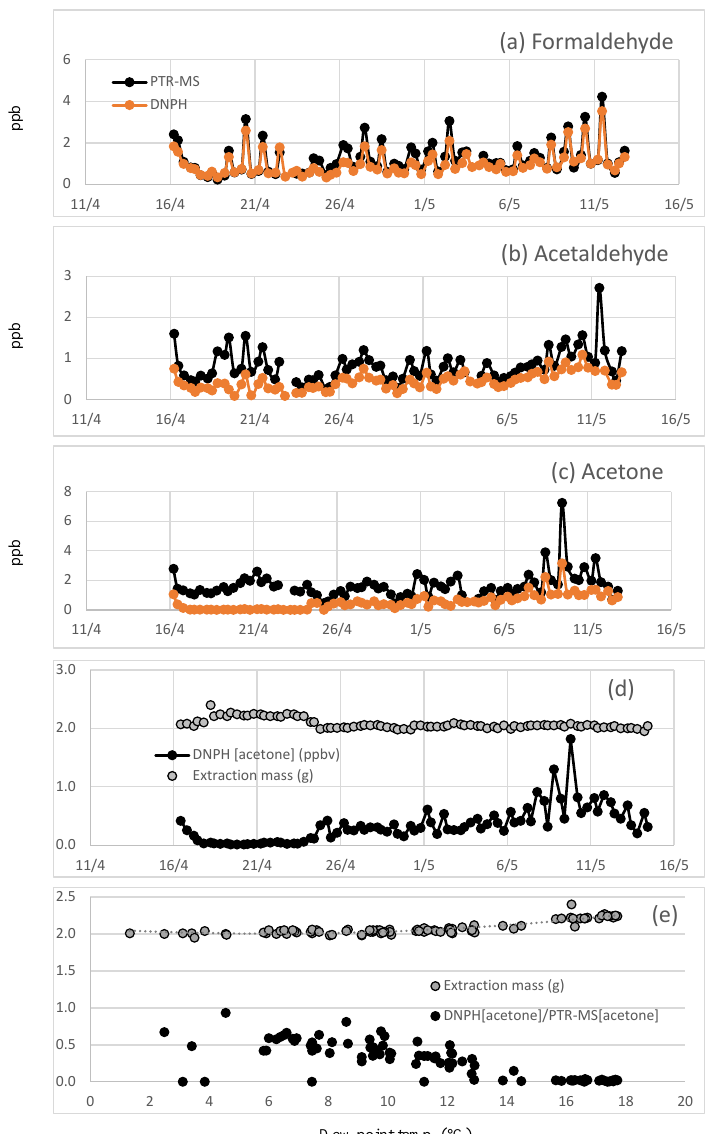
Figure 3. Time series of (a) formaldehyde, (b) acetaldehyde and (c) acetone measured in the DNPH samples and by the PTR-MS in SPS 2. Also shown is the (d) time series of the DNPH reported acetone concentration and extraction mass and (e) the DNPH extraction masses plotted vs. dew point along with the ratio of DNPH reported acetone data to the PTR-MS reported acetone data (DNPH[acetone] / PTR- MS[acetone] plotted vs. dew